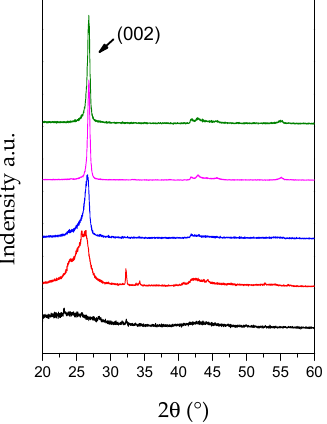
Figure 9. XRD patterns recorded on samples LiBN01 ( black ), LiBN02 ( red ), LiBN03 ( blue ), LiBN04 ( magenta ) and LiBN05 ( green ).